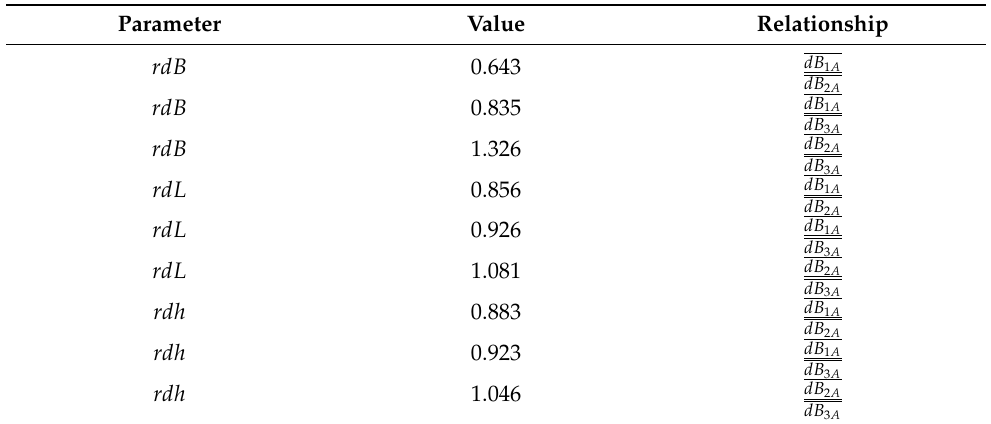
Table 2. The results of parameters ( rdB , rdL , rdh ) .